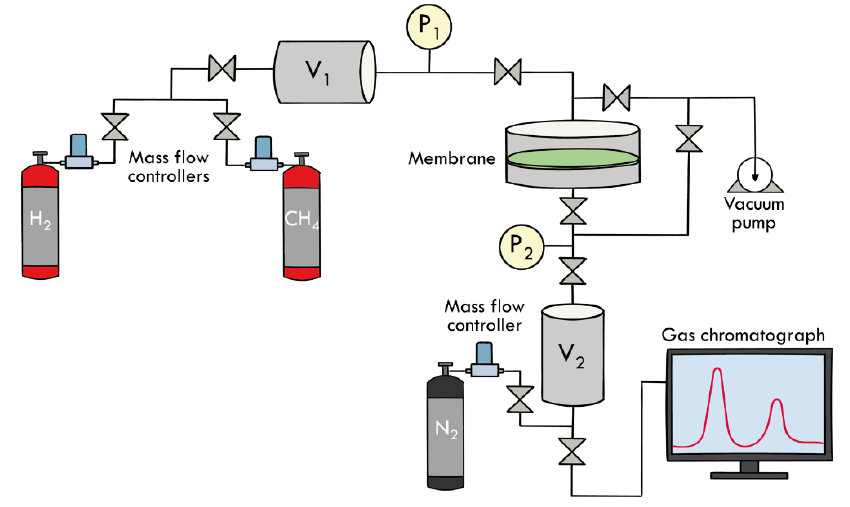
Figure 2. Schematic representation of the gas separation